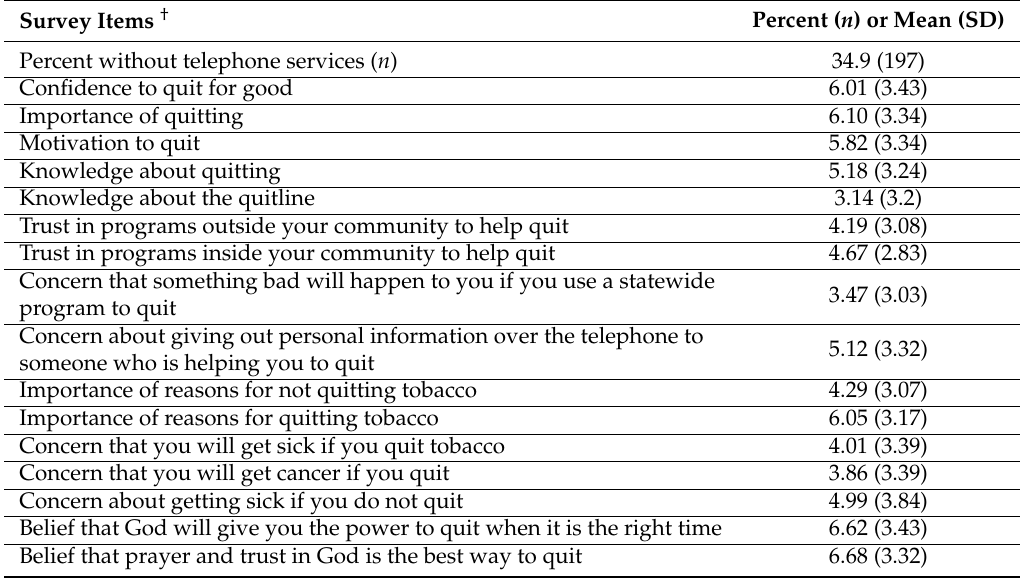
Table 2. Resources, knowledge, attitudes, and beliefs associated with quitting tobacco and using the quitline among current/former tobacco users.